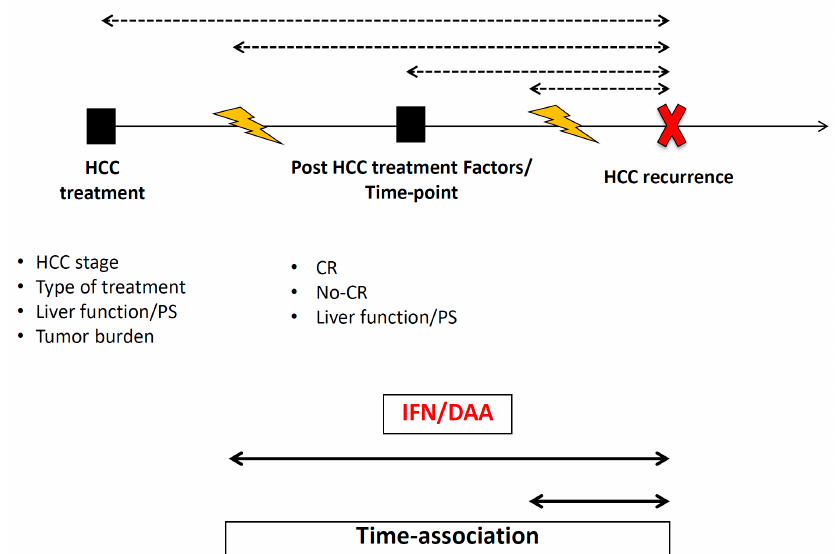
Figure 1. The minimum information that the studies need to report in order to disregard the alarm. The black squares represent the start point of the analysis and the note below each black square indicates the minimum information that the studies need to report at each point. The red X marks the event (HCC recurrence) and the yellow flash represents the start point of HCV treatment. The dotted lines reflect the di ff erent follow-ups according to the selected start point (at HCC treatment, at post-HCC treatment or at the time of starting HCV treatment regardless of the type of treatment). The continuous lines represent the time between starting HCV treatment and the date of HCC recurrence diagnosis.